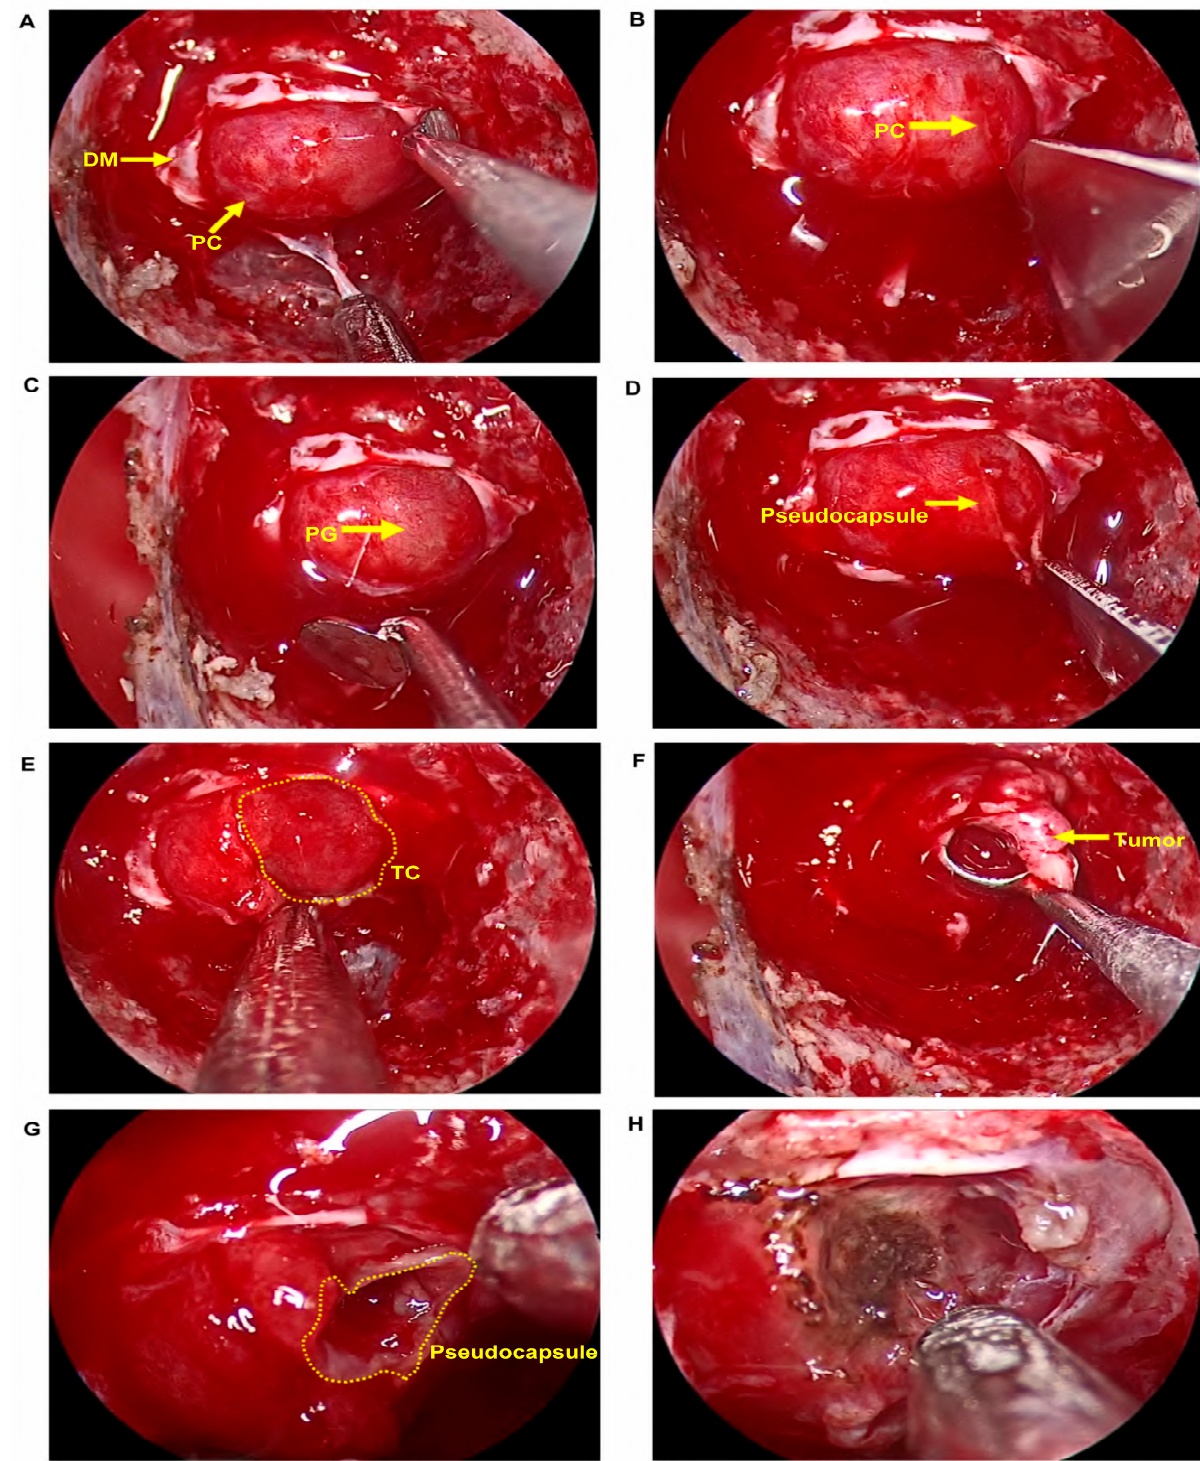
Figure 2. Endoscopic resection of CD. ( A ) The dura was opened without entering the pituitary capsule after the sellar base bone was removed. ( B ) The pituitary capsular was opened in a linear incision. ( C ) Blunting separation to expose the normal pituitary gland. ( D , E ) The pituitary gland was bluntly separated until tumor was fully exposed. ( F ) A pure piecemeal intratumoral resection. ( G ) Pseudocapsule. ( H ) The pseudocapsule was dissected thoroughly. Abbreviations: CD, Cushing’s disease; DM, dura mater; PC, pituitary capsule; PG, pituitary gland; TC, tumor circumscription.